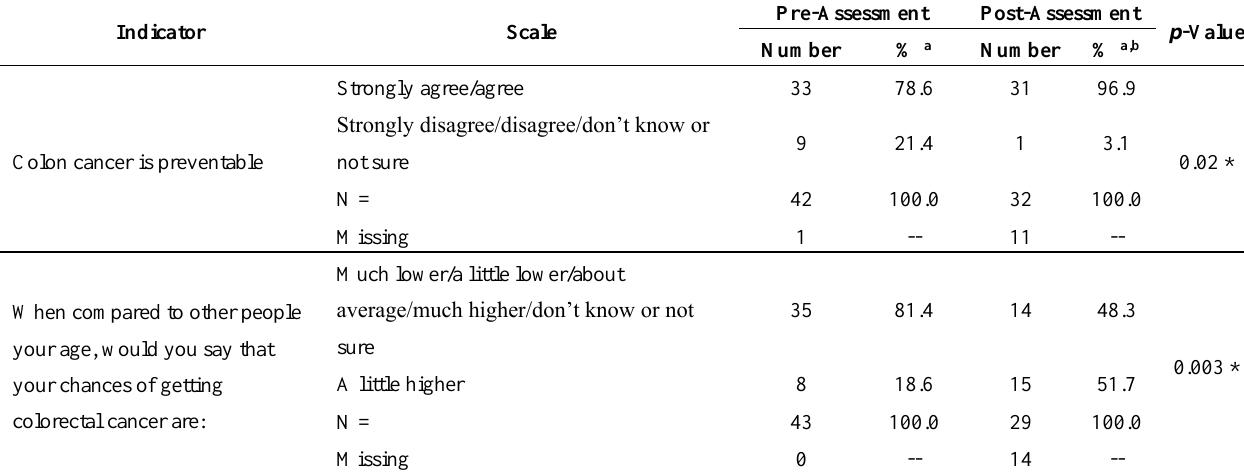
Table 3. Attitudes, beliefs and practices regarding colorectal cancer and screening among female breast cancer survivors participating in the colorectal cancer prevention and screening Power of Prevention focus groups, Missouri,